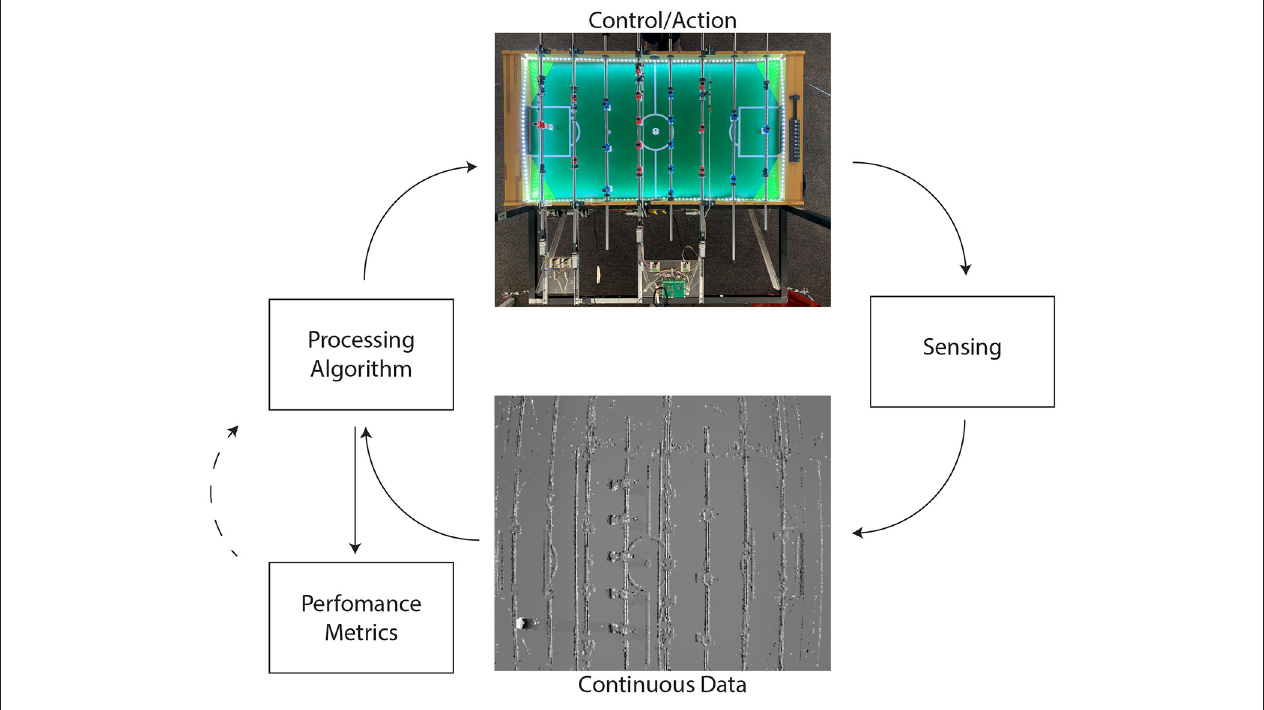
FIGURE 4 | Schematic of the closed-loop robotic foosball